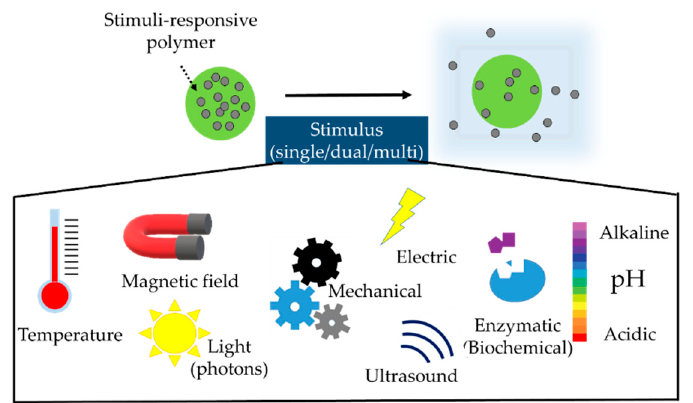
Figure 4. Smart release stimuli via microencapsulation.